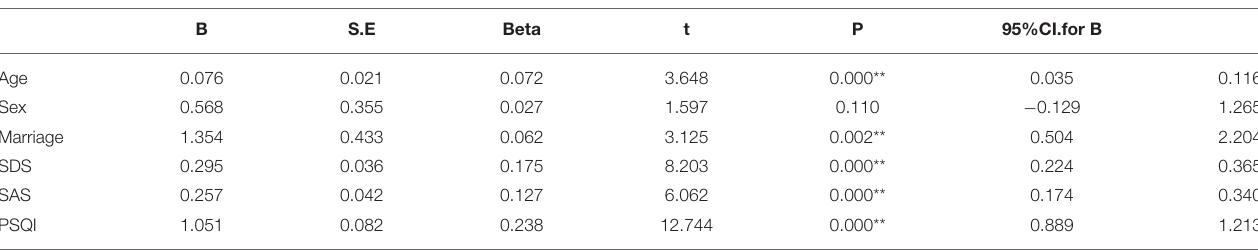
TABLE 7 | Multiple regression results of IES-R total score and related variables among non-depressed group. B S.E Beta P 95%CI.for